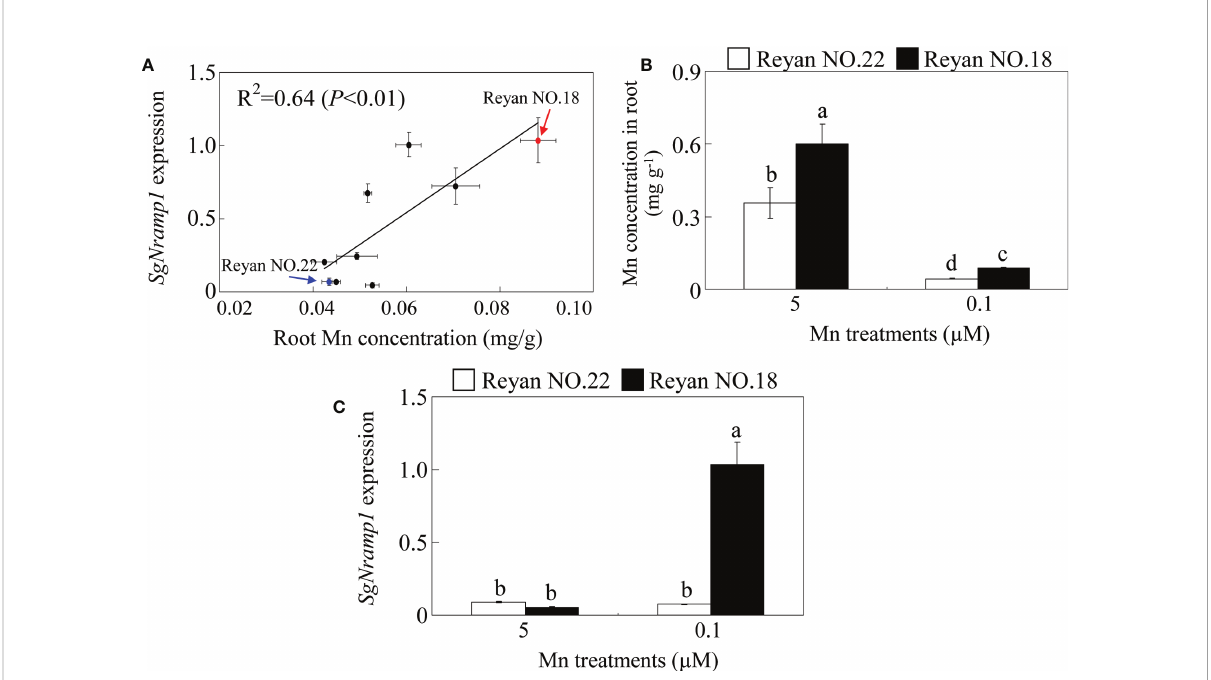
FIGURE 5 Genotypic variation analysis of SgNramp1 . (A) Analysis of correlation between SgNramp1 expression and root Mn concentration in various stylo cultivars under 0.1 m M MnSO 4 treatments. The red and blue arrows indicate Reyan NO.18 and Reyan NO.22 cultivars, respectively. (B) Mn concentration in roots of Reyan NO.18 and Reyan NO.22 under 0.1 or 5 m M MnSO 4 treatments. (C) Expression of SgNramp1 in roots of Reyan NO.18 and Reyan NO.22 under 0.1 or 5 m M MnSO 4 treatments. Fourteen-day-old stylo seedlings were subjected to 0.1 or 5 m M MnSO 4 treatments for 7 days that were considered as low Mn and normal Mn treatments, respectively. Stylo roots were used for SgNramp1 expression analysis and Mn determination. Data are means of three biological replicates with SE. Different letters represent signi fi cant differences at P <